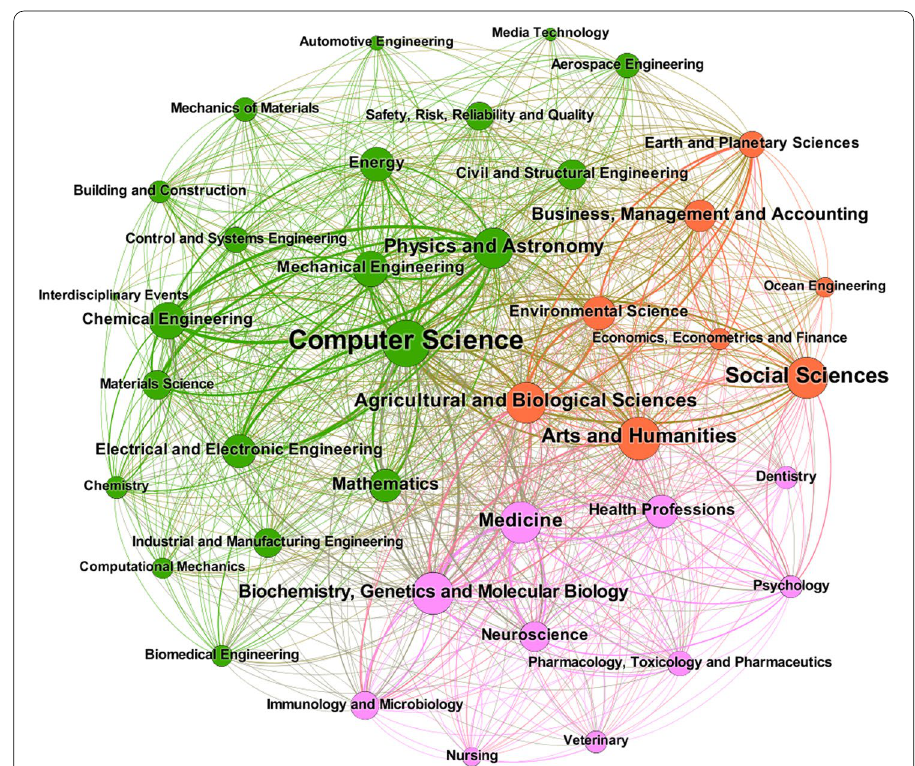
Fig. 4 The field of interest network. The color of a node indicates its community. The size of a node corresponds to its PageRank value, and the size of its label represents its betweenness centrality. An edge’s thickness shows its